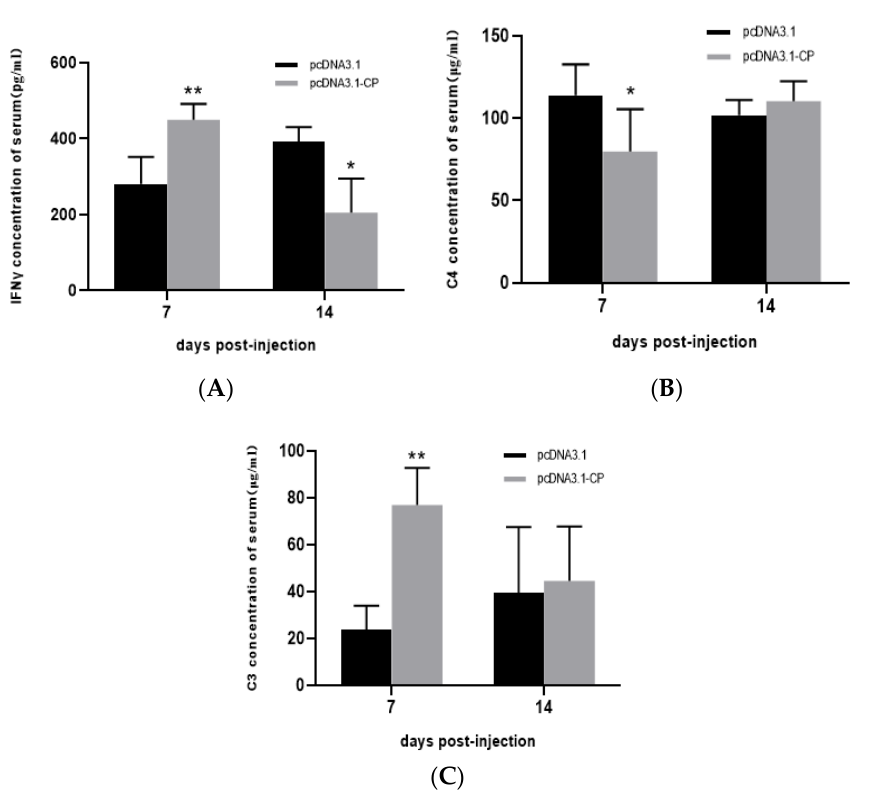
Figure 8. Cytokine levels in serum using ELISA after two injections of pcDNA3.1-CP (*: p < 0.05; **: p < 0.01).